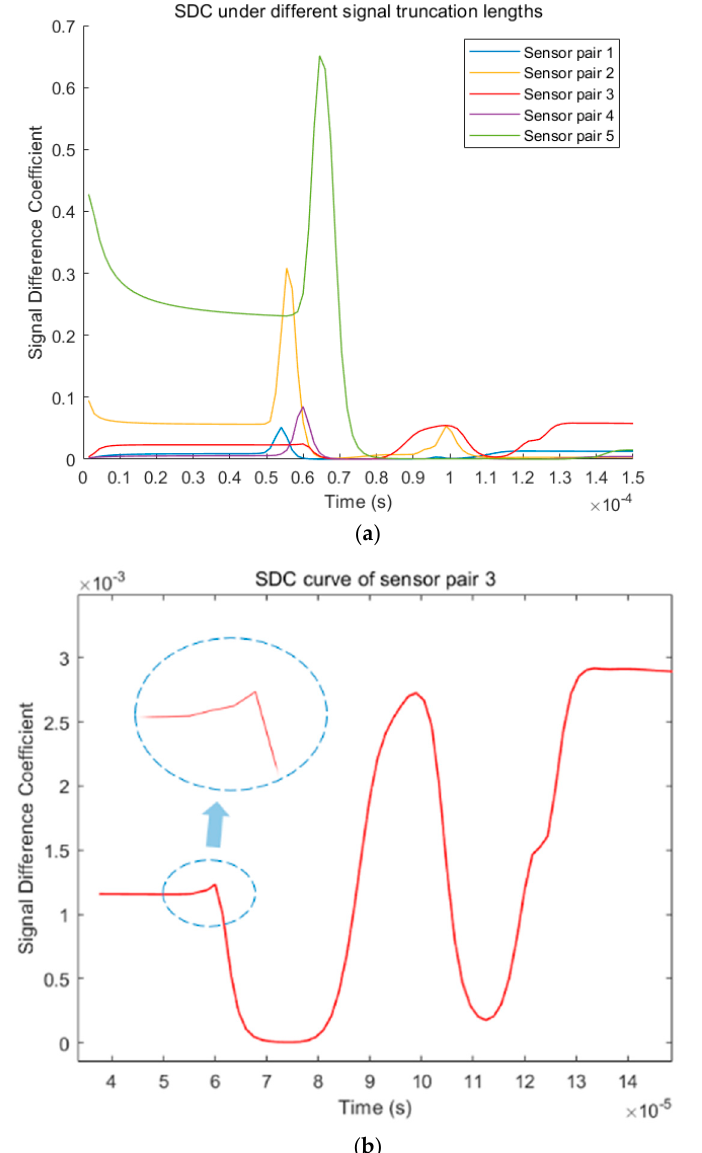
Figure 3. Signal difference analysis of healthy signal and damaged signal under different truncated length: ( a ) SDC curves of different sensor pairs; ( b ) SDC curves of sensor pair 3.